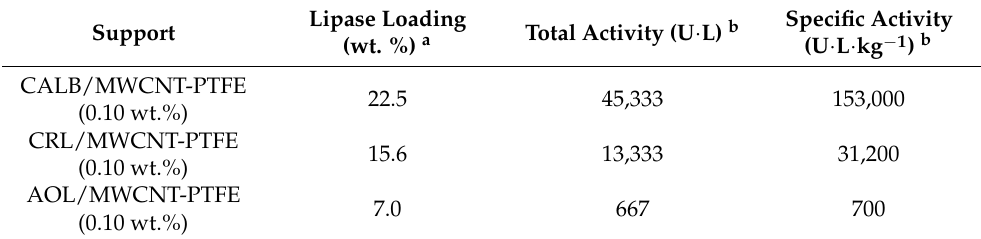
Table 2. The properties of MWCNT/PTFE hybrid materials used in this